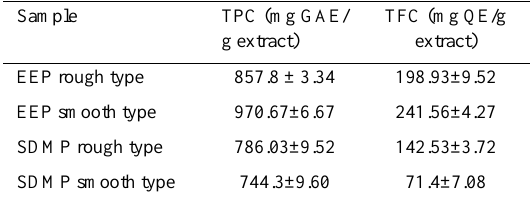
Fig.2. SEM image: (a) Unencapsulated smooth EEP; (b) Unencapsulated rough EEP; (c) SDMP smooth type; (d) SDMP rough type; and (e)